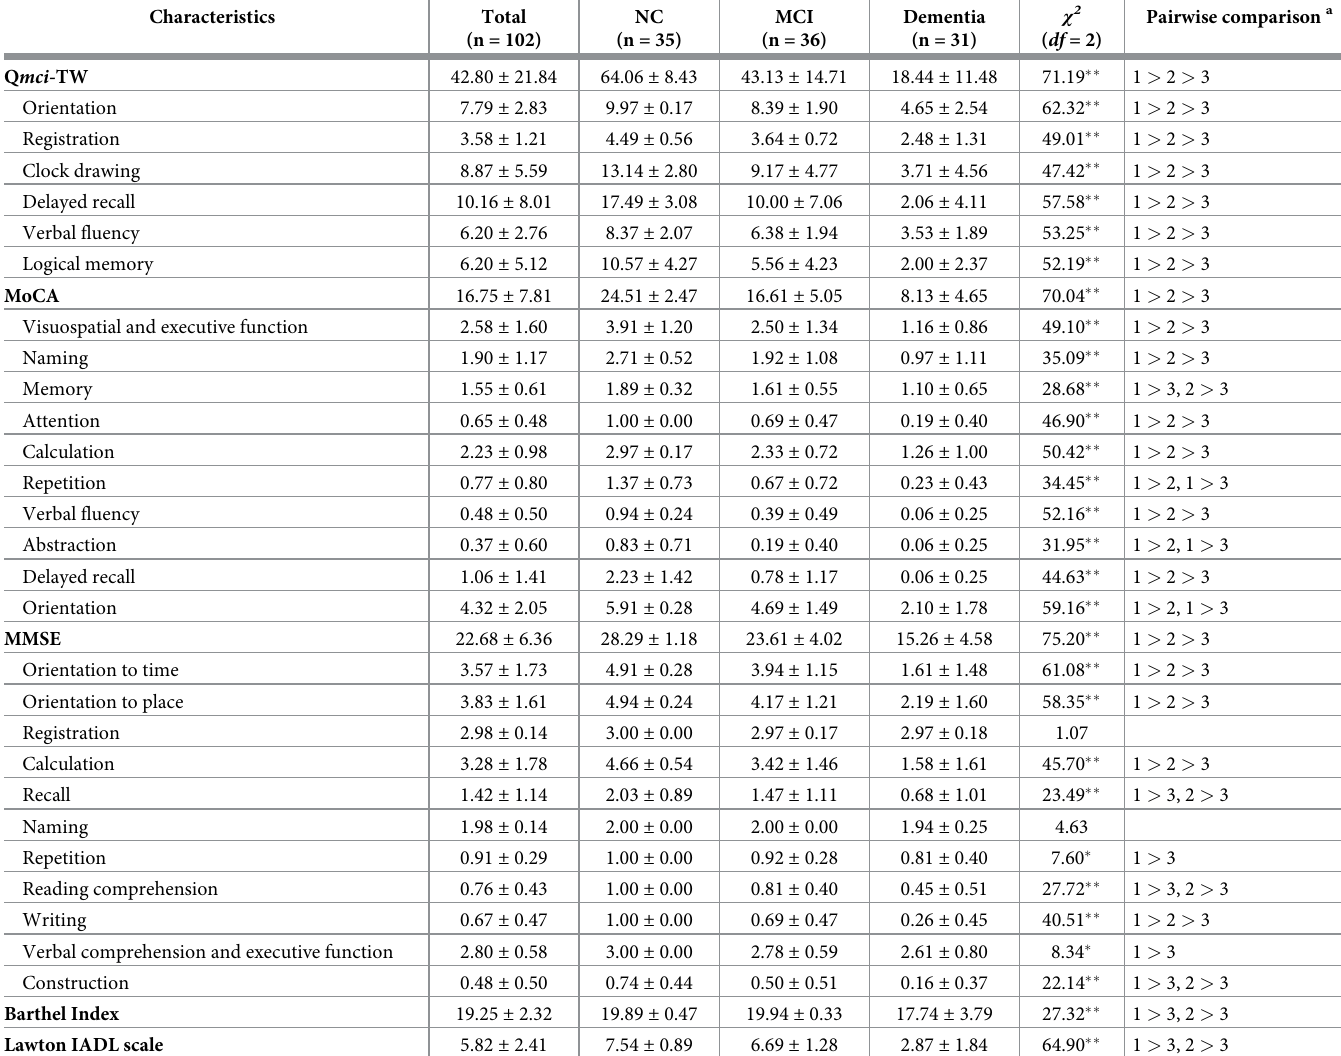
Table 2. The clinical characteristics of the participants stratified by NC, MCI and dementia.